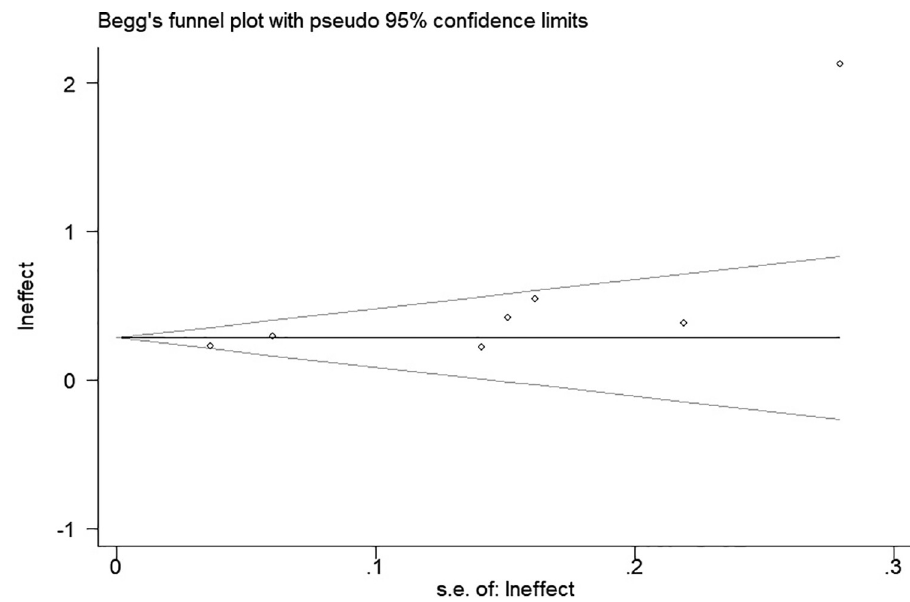
Fig 3. Begg’s test. Exposure to biomass burning